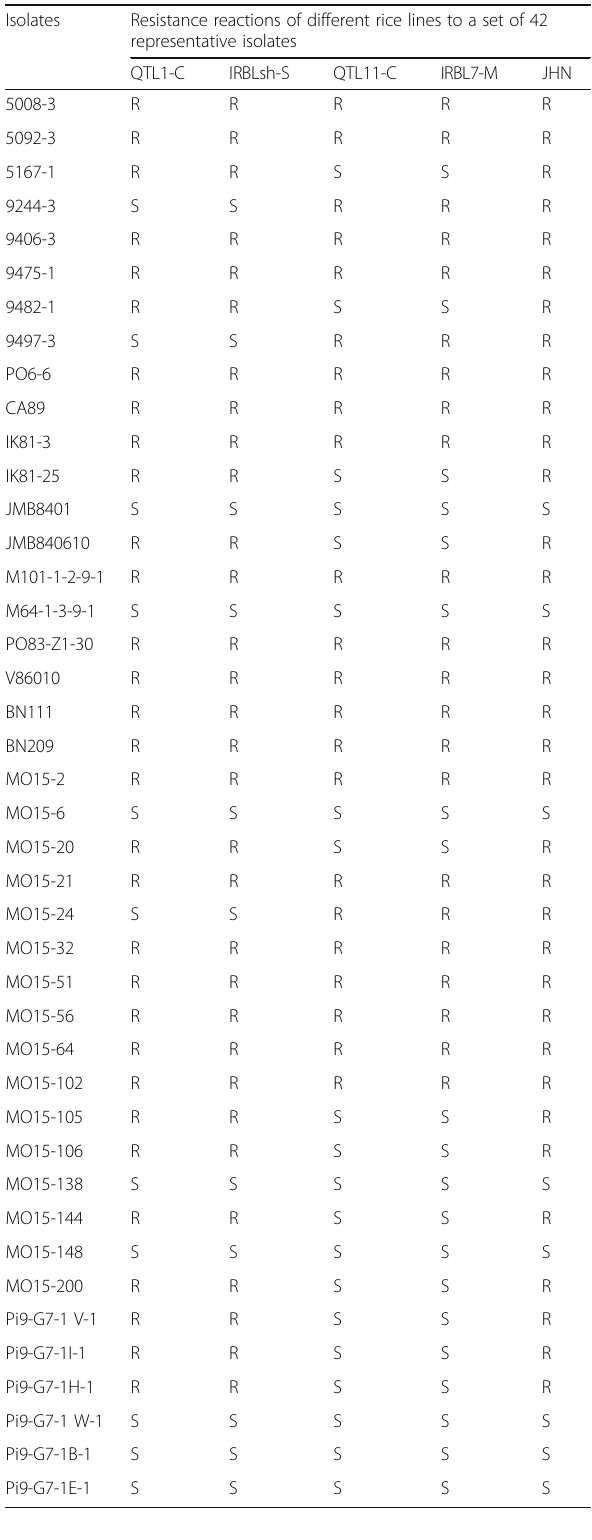
Table 1 The disease spectrum of QTL1-C, QTL11-C, IRBLsh-S, IRBL7-M, and JHN against 42 representative Philippine blast isolates Isolates Resistance reactions of different rice lines to a set of 42 representative